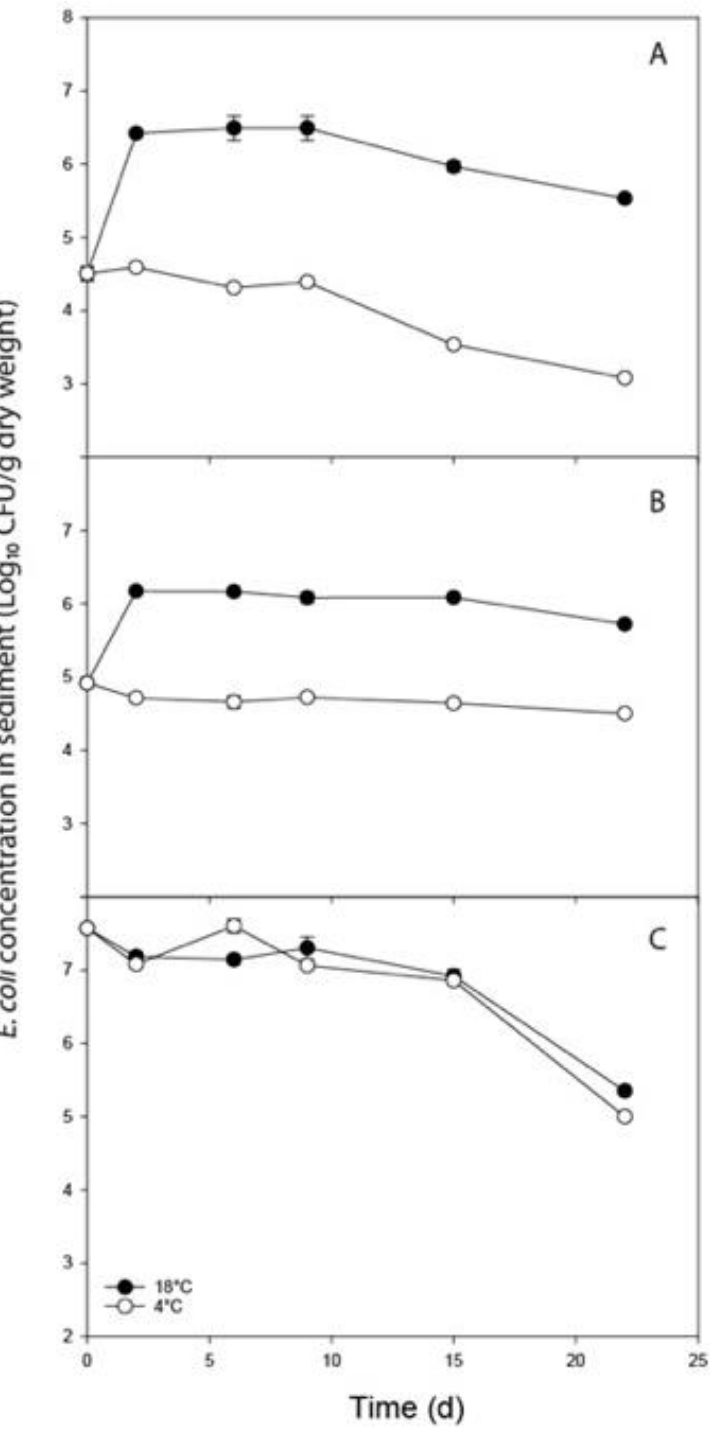
Figure 1. Persistence profiles in streambed sediment of E. coli sourced from ( A ) dairy cow, ( B ) red deer, and ( C ) greylag goose faeces. Data points are the mean of four replicates ± standard error. Table 1. Linear model parameter values for E. coli decay in sediment contaminated with different faecal types; superscript letters indicate grouping information for k using Tukey ’s pairwise compar- isons.